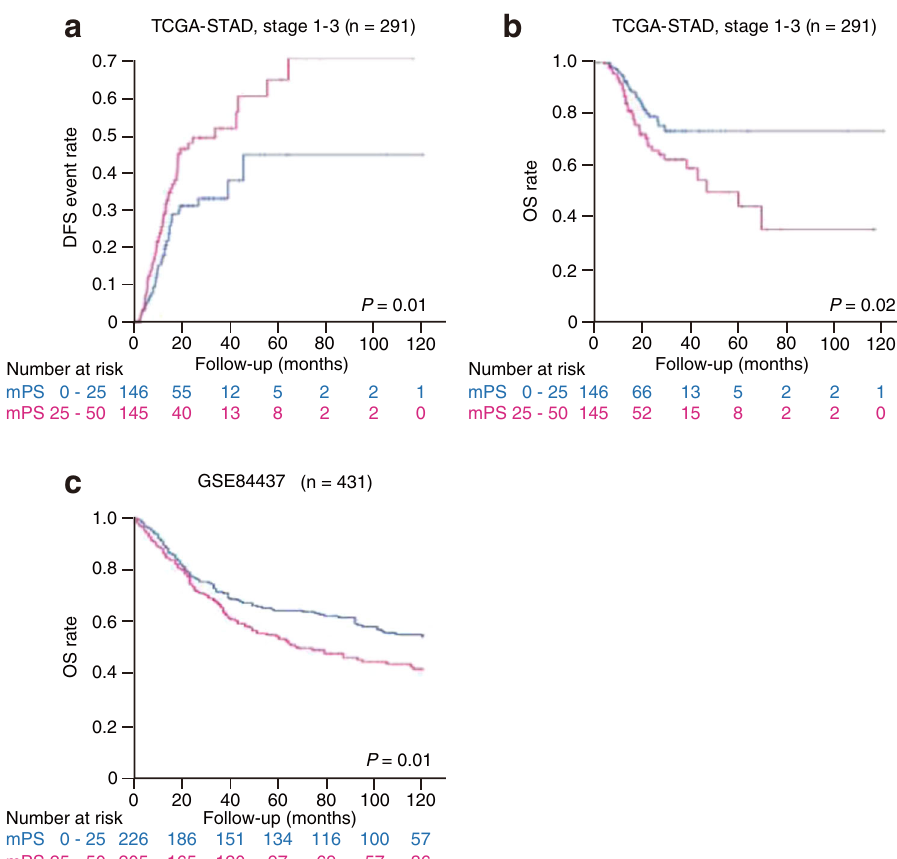
Fig. 5 mPS_colon universally strati fi es patients with gastrointestinal tumors. a , b Kaplan – Meier curves of disease-free survival (DFS) ( a ) or overall survival (OS) ( b ) according to mPS_colon for metastasis-free gastric cancer patients in the TCGA-STAD cohort. The log-rank P values are shown. c Kaplan – Meier curves of OS according to mPS_colon for East Asian gastric cancer patients in the GSE84437 cohort. Only patients with available information are